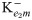
Identified bow-tie network and its schematic diagram.(A)The bow-tie structure identified from the protein functional networks. The pointed arrows represent the activation action by source onto the target gene and the flattened end arrows suggest inhibitory action. (B) Schematic representation of the structure used for ODE modeling. Kd1d2, Ke1e2, Ka1a2, Kb1m, Kd2m, Ke2m, Ke2m-, Kf1m and Kc1m represents the upstream (input to the core of the bow-tie structure) rate constants of the signaling network. And Kmn, Ka2a3, Kna3, Kna3-, Knb2, Knd3, Knd3-, Kne3, Knf2 and Knf2- represents the downstream rate constants of the network structure. Da1, Da2, Da3, Da4, Db1, Db2, Dc1, Dd1, Dd2, Dd3, De1, De2, De3, Df1, Df2, Dm, and Dn represent the decay rate constant of the activated components A1, A2, A3, A4, B1, B2, C1, D1, D2, D3, E1, E2, E3, F1, F2, M, and N respectively. The constants Ke2m, Knd3, Kna3, Knf2 represents the activation kinetic constants for basal production of the components M, D3, A3, and F2 respectively.